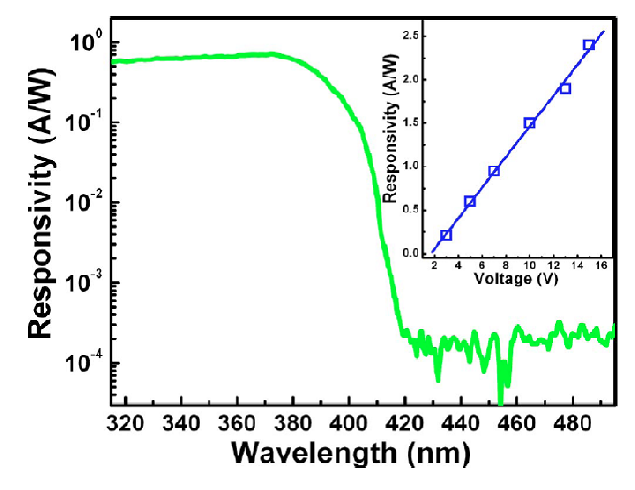
Figure 6. Photoresponse of the photodetector at 5 V bias; the inset shows the dependence of the responsivity of the photodetector at 370 nm on applied bias